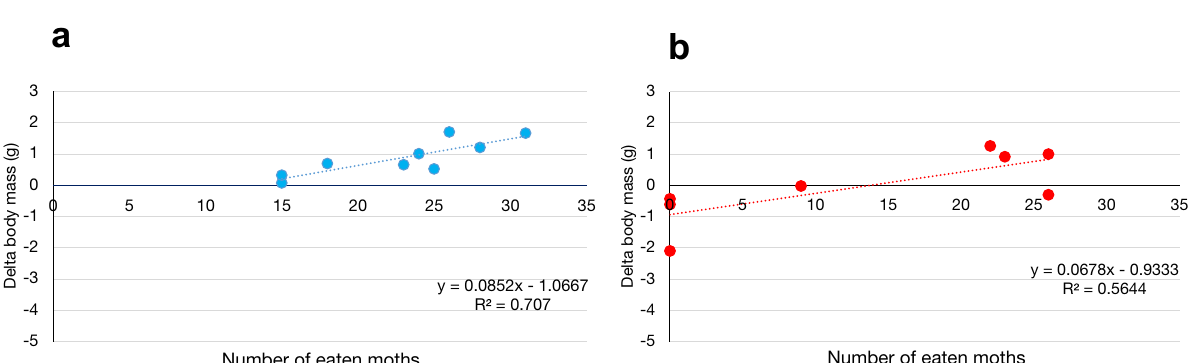
Figure 6. α-Diversity descriptors in the gut microbiota communities. ( a ) Richness (S) ( b ) Shannon (H) and ( c ) Evenness (J) for the gut microbiota of IL (island lizard), IL_F (fed island lizard), MA (mainland lizard) and MA_F (fed mainland lizard). Square brackets indicate statistically significant differences.